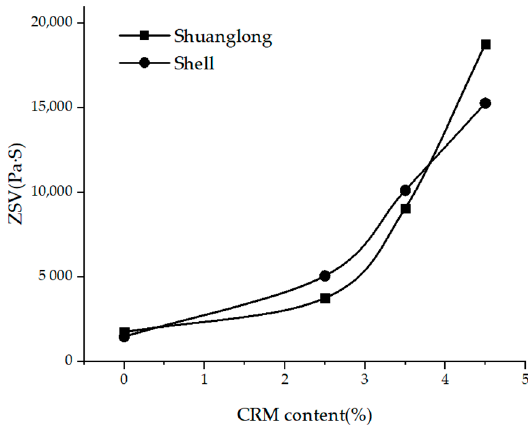
Figure 8. ZSV of hybrid modified asphalt binders with different SBS contents.